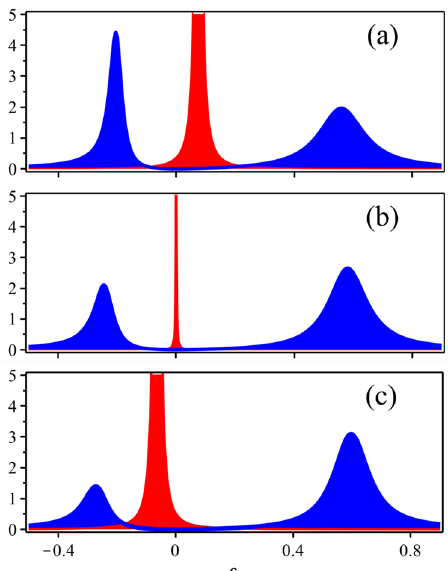
Fig. 2 Spectral functions crossing the Luttinger surface. Physical particle, A ( ϵ , k ) in blue, and ‘ quasiparticle ’ , A ϵ , k ) in red, densities of states for k qp ( along the path Y → M . a – c refer, respectively, to k = (0.8 k L , π ), k = ( k L , π ) on the Luttiger surface, and k = (1.1 k L , π ). We use ϵ ( k ) and ϵ * ( k ) as in Fig. 1 and take Δ = 0.4, so that ϵ ( k ) ϵ * ( k ) + Δ 2 > 0 throughout the Brillouin zone, and γ = 1. We also added a fi nite broadening to make the quasiparticle visible on the Luttinger surface.